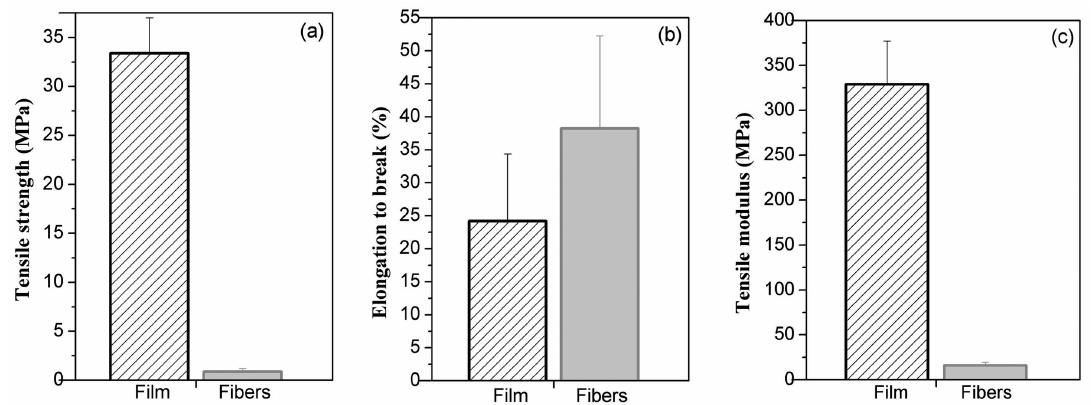
Figure 9. Tensile properties of PHB thermo-compression molded film and nanofibers mat: (a) tensile strength, (b) elongation to break and (c) tensile